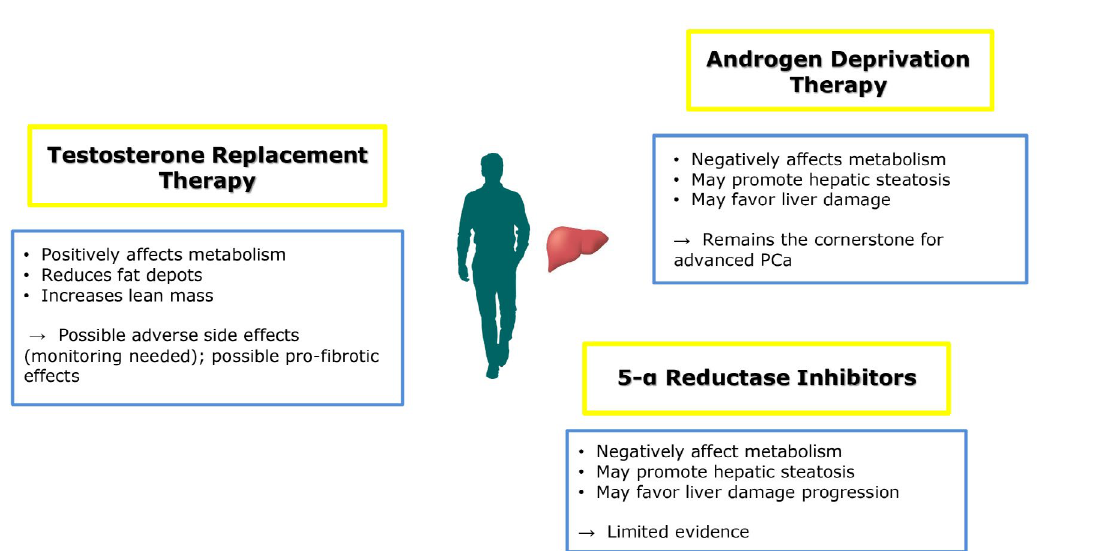
Figure 2. Hormonal therapy in men and NAFLD risk. PCa: prostate